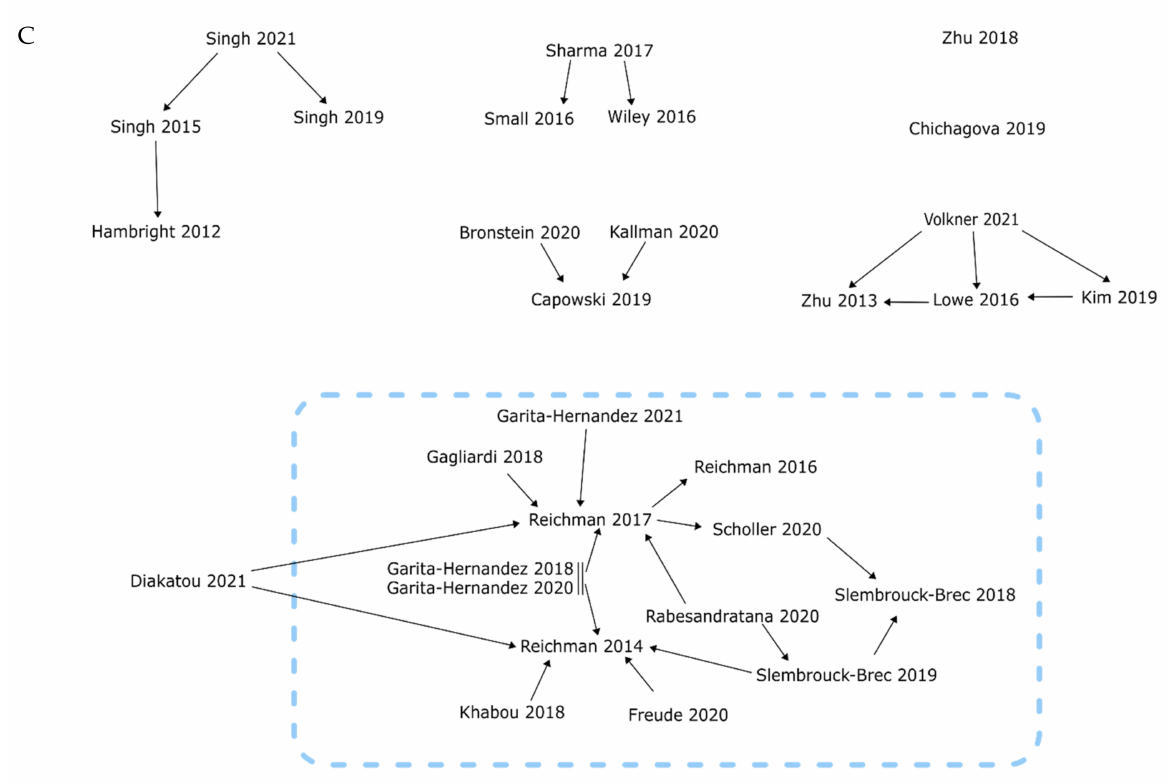
Figure 7. The evolution of organoid protocols. ( A – C ) Our literature search revealed that a majority of retinal organoid protocols had developed from three major papers described in Section 4.1 (highlighted in red boxes) before being adapted to fit individual needs. We also found that some protocols were isolated in specific groups (highlighted in blue boxes) but were still well-established within that group. There were also a handful of “stand-alone” protocols that had been rarely used. Some more recent methods combine multiple protocols, shown by multiple arrows or highlighted in green. ( A ) We found that many manuscripts were based on the methods of Kuwahara et al. [127] and Nakano et al. [154], leading to a high frequency of protocols generating embryoid bodies using single cells. On the other hand, some protocols were used mainly by a single group (highlighted in blue). ( B ) Zhong et al. [155] was the most commonly referenced method of generating retinal organoids, building upon the previous work of Meyer et al. [135,144], and outlines how this protocol, a method with relatively few steps or additional supplements, has been used as a base for many models, being adapted as needed. ( C ) Alongside stand-alone protocols used solely by a single group (in blue), there were also a small number of manuscripts that did not relate to other methods. All papers included either produced retinal organoids, or were referenced as a method of producing retinal organoids